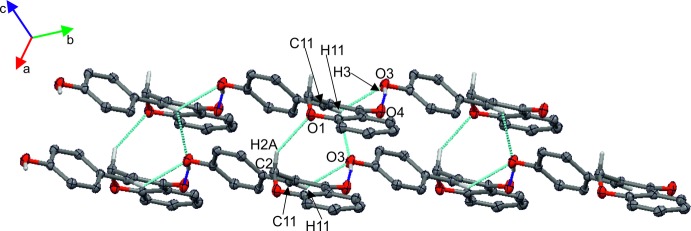
Partial packing of compound I showing the O—H⋯O (blue dotted lines) and C—H⋯O (cyan dotted lines) hydrogen-bonding network.